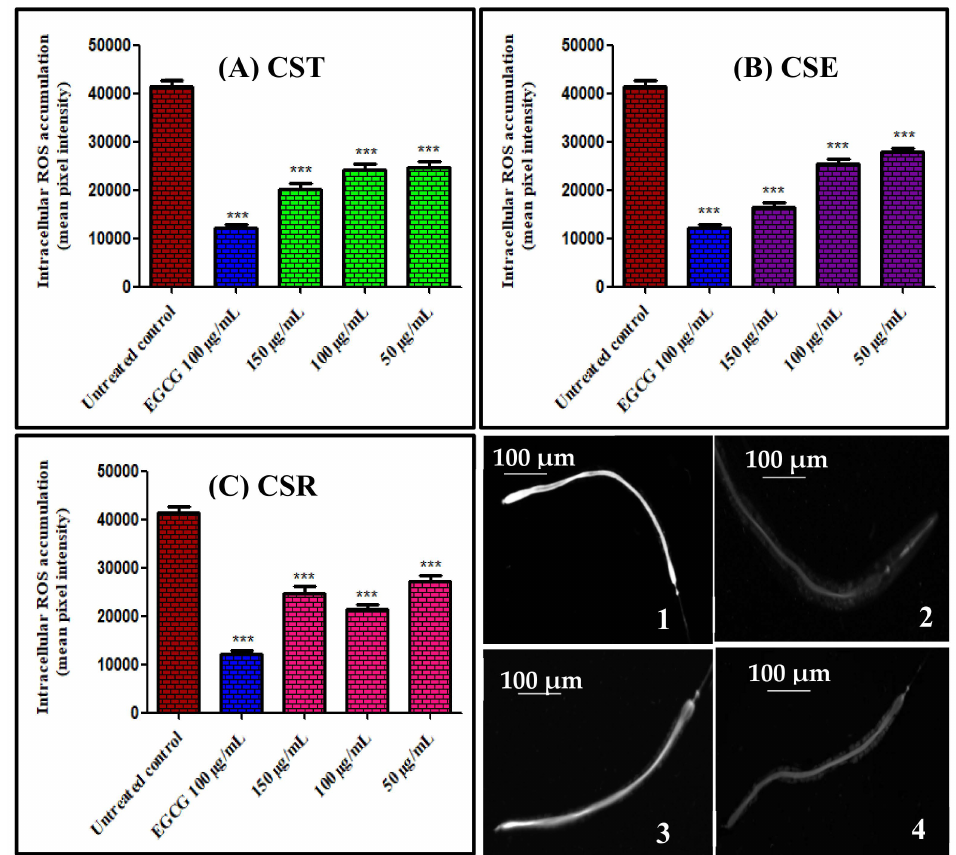
Figure 2. Intercellular ROS accumulation in Caenorhabditis elegans pre-treated with different concen- trations (50, 100, and 150 µ g/mL) of extracts and fractions of C. speciosum leaves; ( A ) CST, ( B ) CSE, and ( C ) CSR estimated as mean pixel intensity. Images of C. elegans by fluorescence microscopy (1) untreated control group, (2) pre-treated with 100 µ g/mL of EGCG, (3) pre-treated with 50 µ g/mL of CSR, and (4) pre-treated with 150 µ g/mL of CSE; untreated control receives juglone treatment; EGCG = Epigallocatechin gallate (100 µ g/mL) after juglone treatment; CST, CSE, and CSR groups receives (50, 100, and 150 µ g/mL) of CST, CSE, and CSR after juglone treatment; *** p <